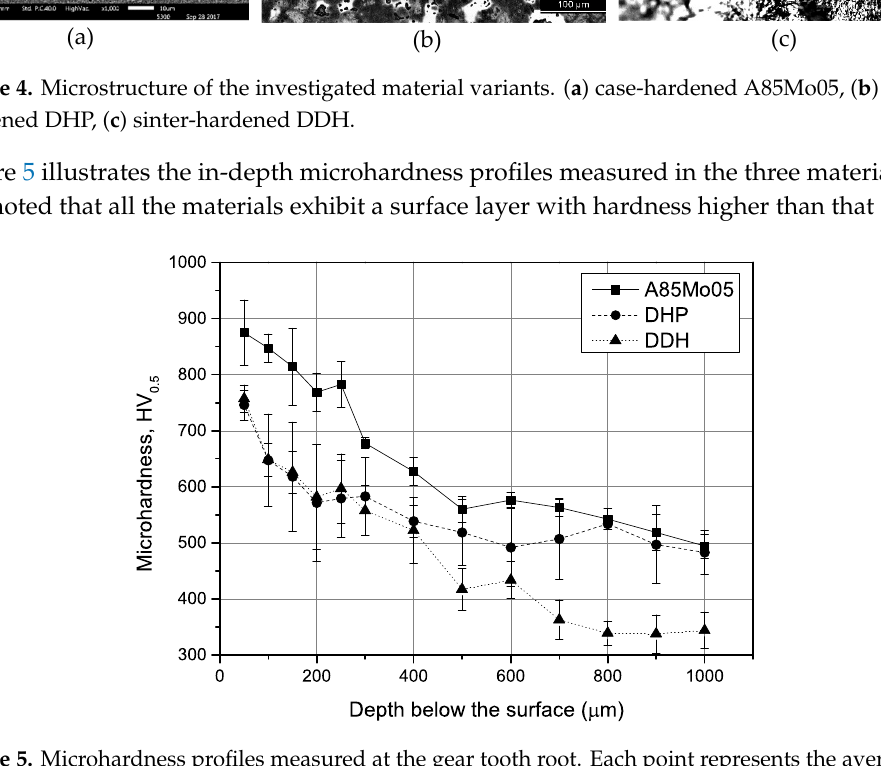
Figure 5. Microhardness profiles measured at the gear tooth root. Each point represents the average of five measurements.